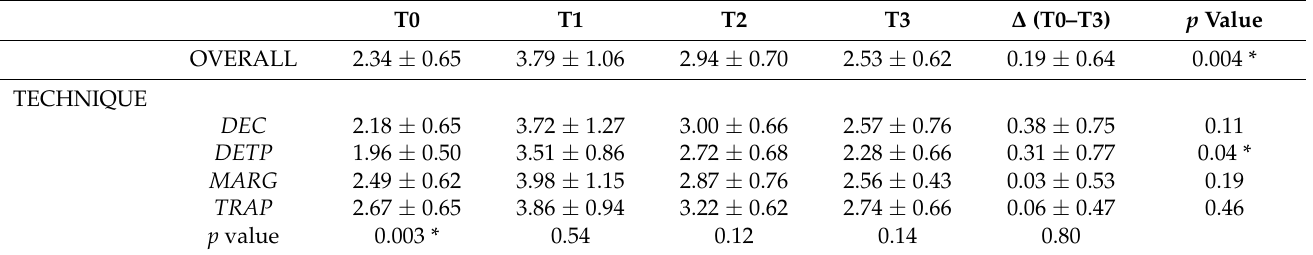
Table 6. Second molar buccal site PPD. Values are presented in mm as mean ( ± standard deviation). T0 T1 T2 T3 ∆ (T0–T3)